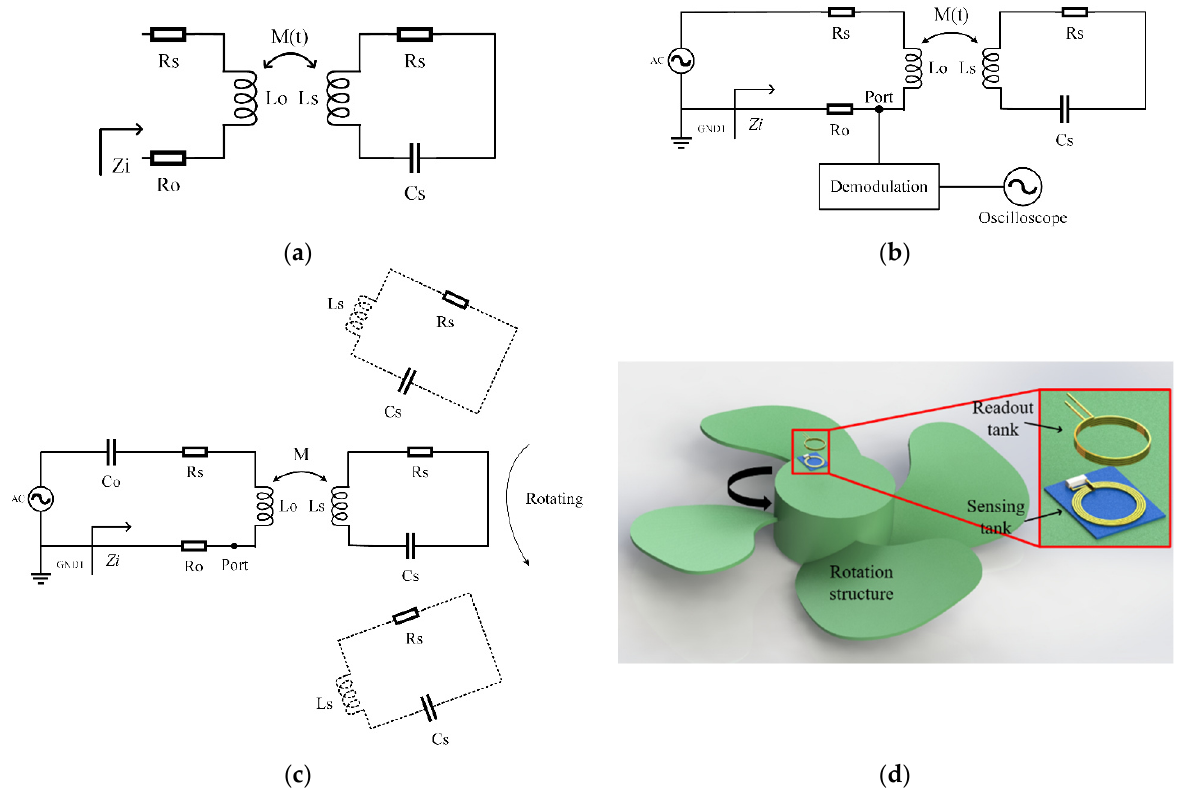
Figure 1. Operation principle of the rotational speed measurement based on a LC wireless sensor: ( a ) schematic circuit diagram of a traditional LC wireless sensor; ( b ) schematic circuit diagram of a traditional modulation voltage measurement; ( c ) schematic circuit diagram of the readout loop with a matched capacitor; ( d ) 3D modeling of the LC rotational speed measuring system.